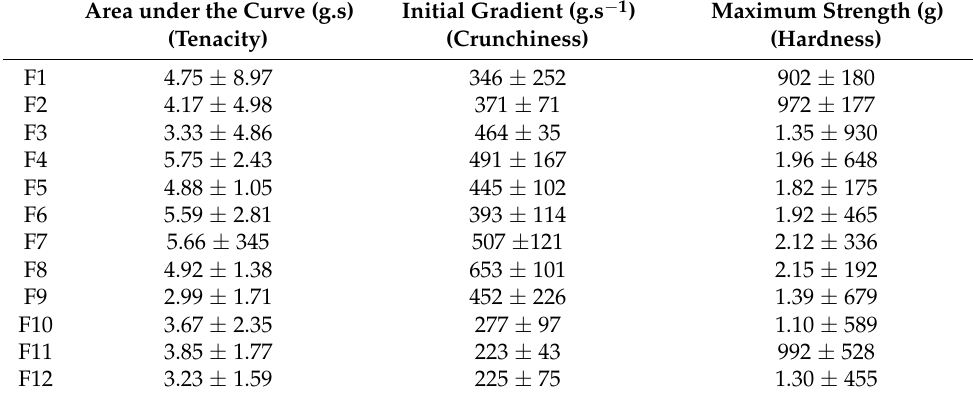
Table 5. Texture analysis of the designed formulations without thermal treatment. Area under the Curve